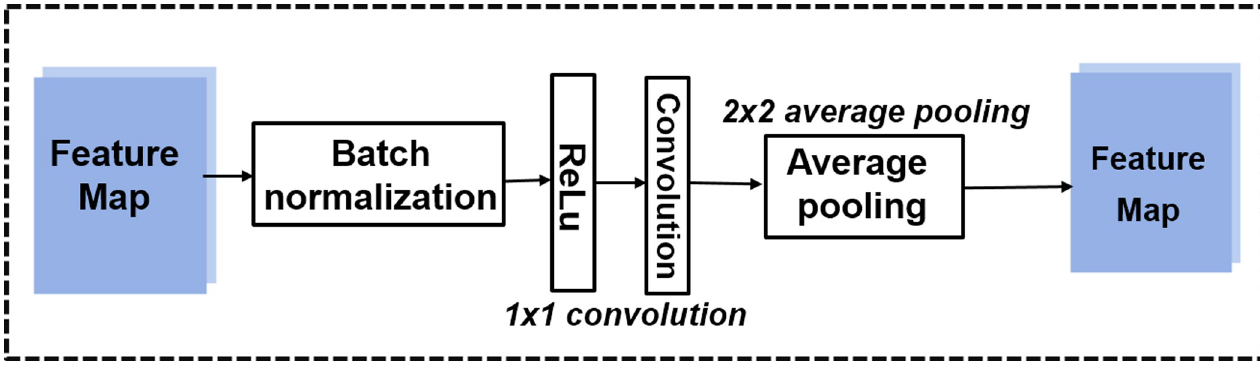
Fig 4. The transition